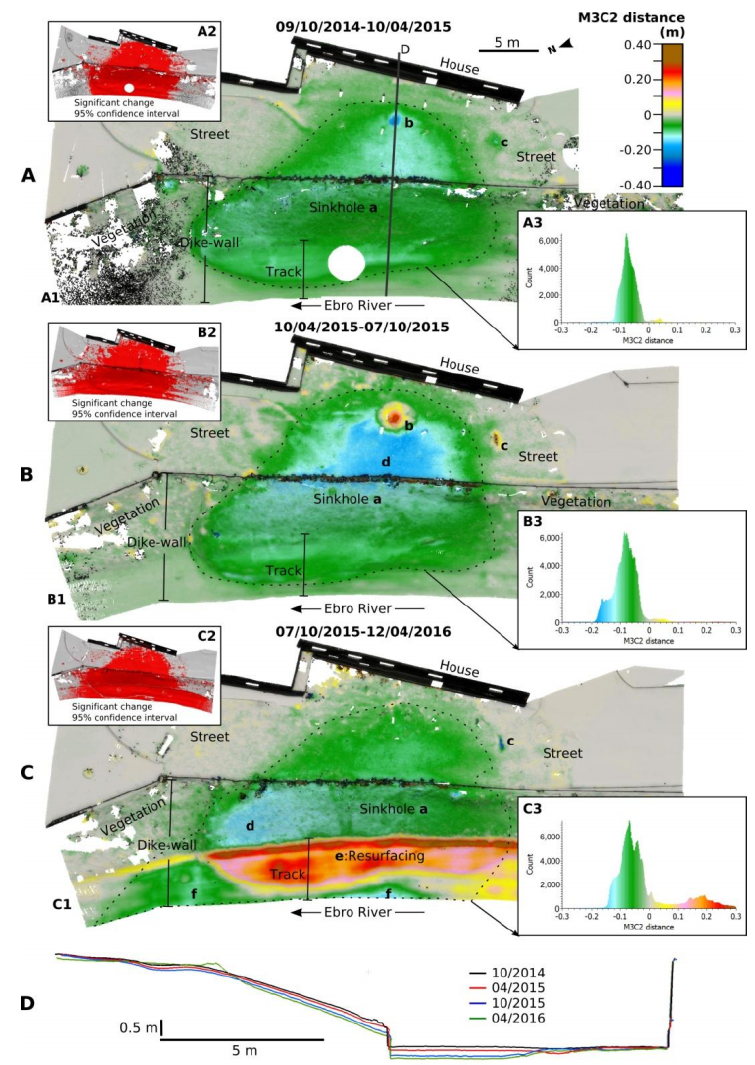
Figure 6. 4D monitoring of surface changes in the Alcal á sinkhole carried out between October 2014 and April 2016. ( A ) Changes from 09/10/2014 to 10/04/2015 (183 days). ( B ) Changes from 10/04/2015 to 07/10/2015 (180 days). ( C ) Changes from 07/10/2015 to 12/04/2016 (188 days). Surface-change frequency histograms are shown on the right of the displacement models. ( D ) Relative displacements along line D, depicted in image